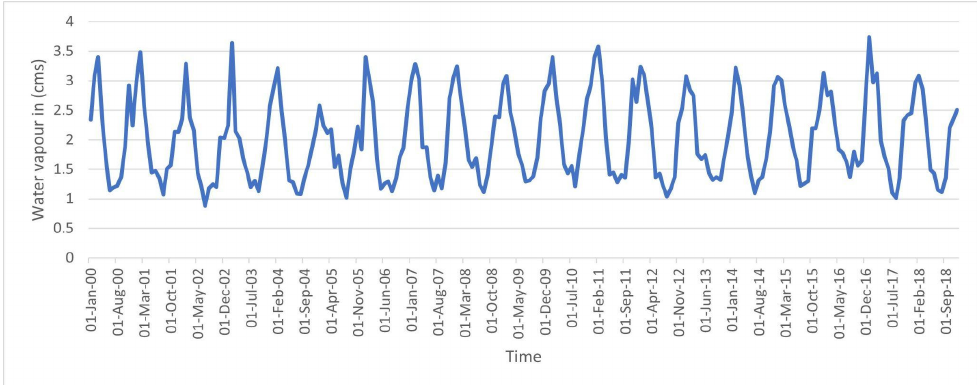
Figure 2. The WV distribution over Narrabri over 15 years estimated by the joint project between the National Centers for Environmental Prediction (NCEP, formerly “NMC”) and the National Center for Atmospheric Research (NCAR). Table 1. WV and AOD estimations, estimated by the joint project between the National Centers for Environmental Prediction (NCEP, formerly “NMC”), the National Center for Atmospheric Research (NCAR), and the atmosphere global product based on Modis MOD08_M3 V6, respectively. Water Vapor (WV) Aerosol Optical Depth (in cm) (AOD) Minimum 0.9 0.02 Maximum 3.7 1.50 Mean 2 0.48 Median 1.9 0.42 Standard Deviation 0.7